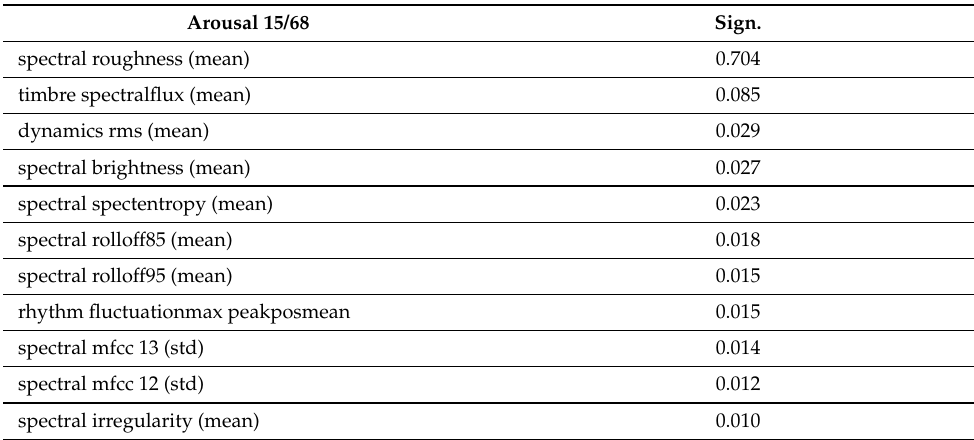
Table 8. Sorted significant features for arousal (15 features) and valence (14 features) by using RFE and applying the RF model on the EmoSoundscape